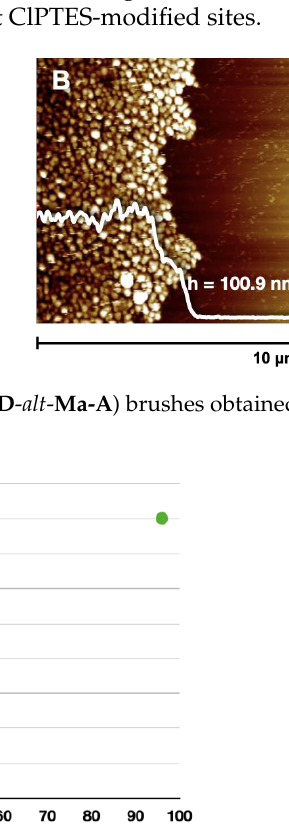
Figure 1. AFM images of poly( St-D - alt - Ma-A ) brushes obtained via RAFT technique: ( A ) after 2 h; ( B ) after 24 h of polymerization. Table 3. Thickness of poly( St-D - alt - Ma-A ) brushes obtained during various times of RAFT polymerization.